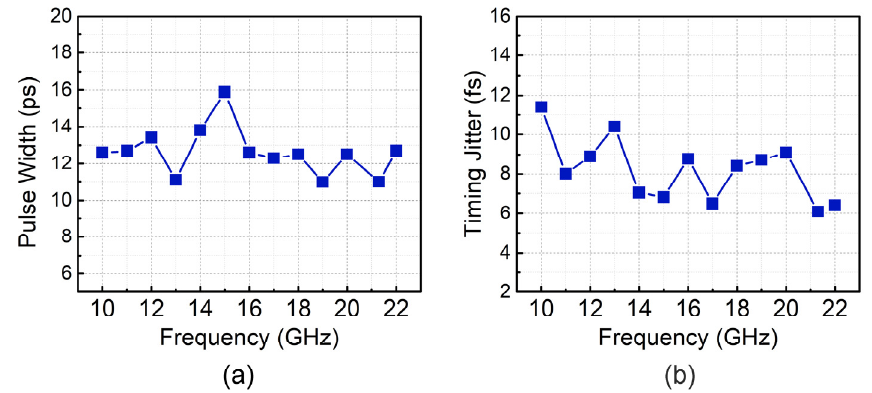
Figure 8. The frequency-tunable regenerative mode-locked laser’s ( a ) pulse width and ( b ) timing jitter.